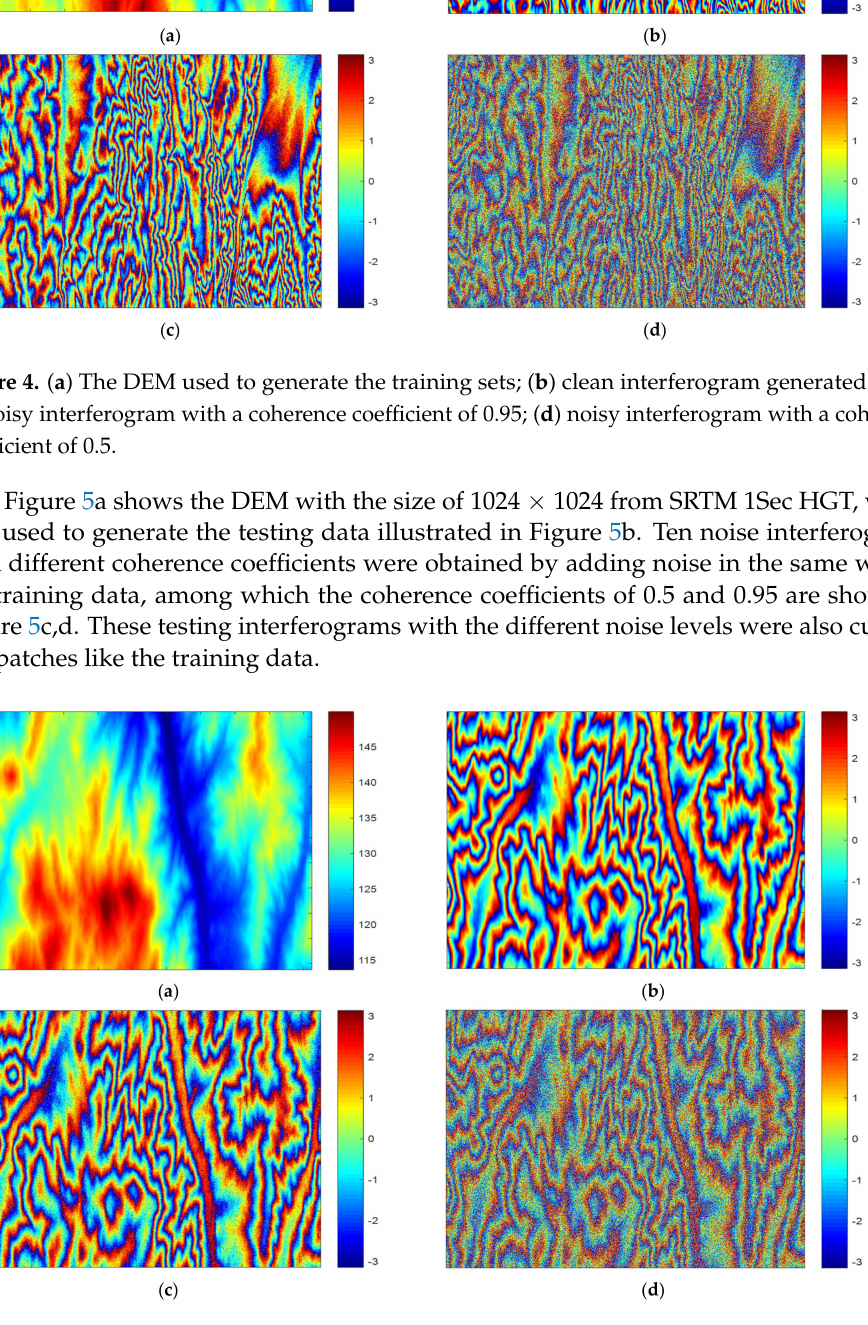
Figure 5. ( a ) The DEM used to generate the testing sets; ( b ) clean interferogram generated by ( a ); ( c ) noisy interferogram with a coherence coefficient of 0.95; ( d ) noisy interferogram with a coherence coefficient of